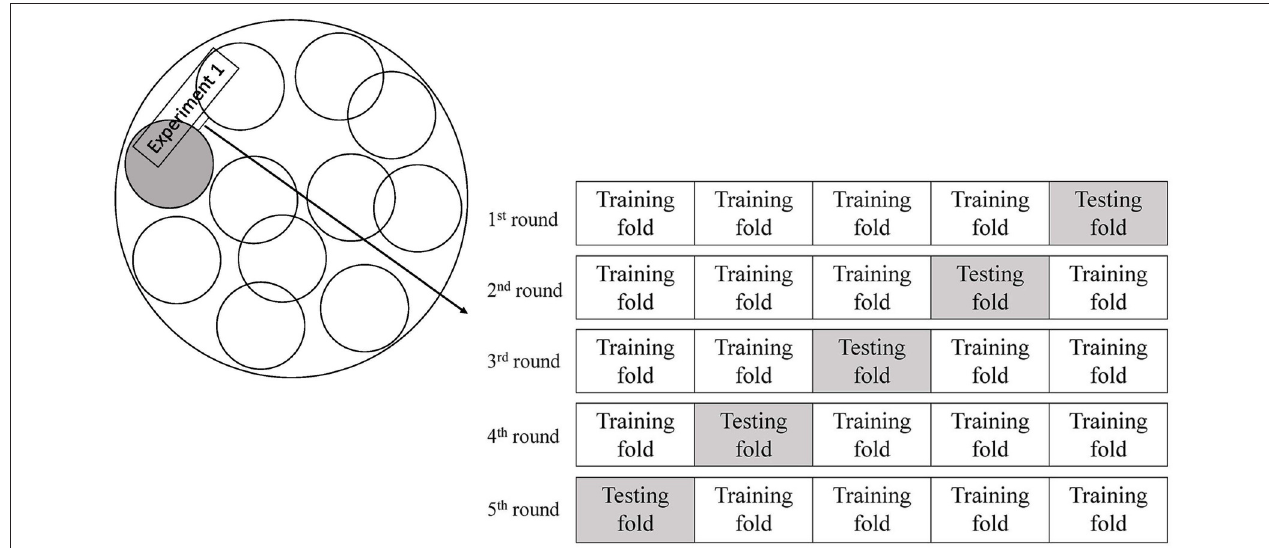
FIGURE 2 | Schematic representation of 10 experiments with 5-fold cross-validation.